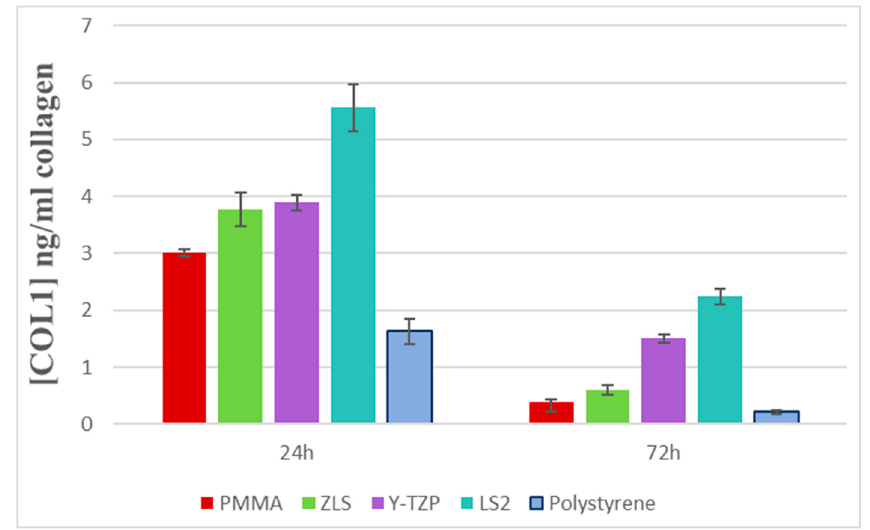
Figure 5. Type I secretion levels at 24 and 72 h.